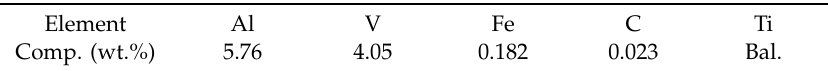
Table 1. Element composition of Ti-6Al-4V.